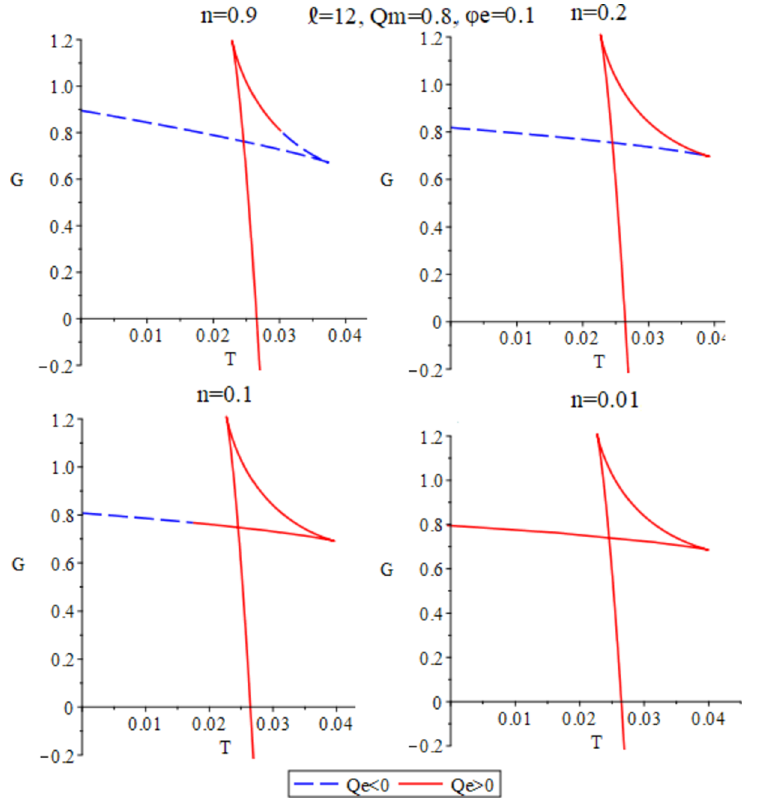
Figure 10 . NUT charge dependence of Charge-changing Transitions. We see that as n increases in size, the small branch becomes negatively charged. The charge transition point eventually moves to the unstable part of the swallowtail, at which point charge-changing transitions become possible. Throughout all these diagrams, M > 0 . This behaviour can occur in cases Ic and